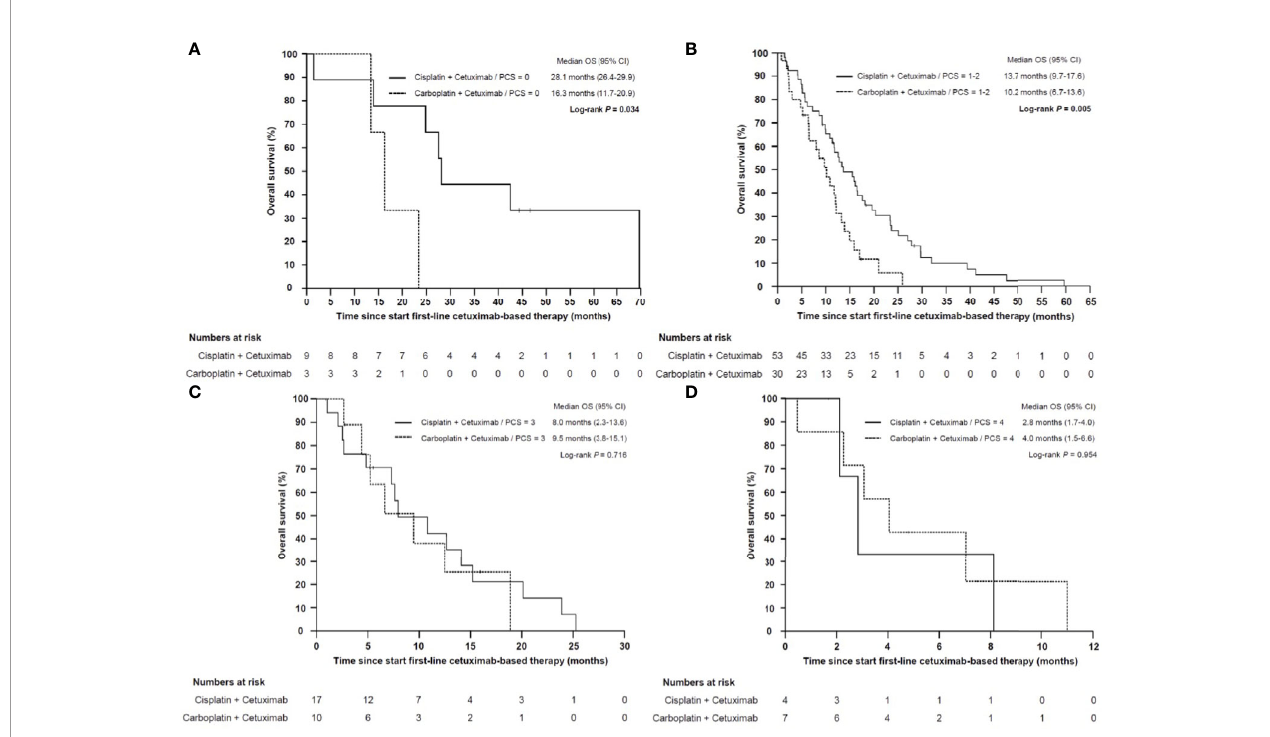
FIGURE 9 | Kaplan – Meier plot for overall survival (OS) from start of cisplatin/cetuximab- vs carboplatin/cetuximab-based fi rst-line therapy in low (A) , intermediate (B) , high (C) and very high risk (D) sub-groups. (A) Patients with low (PCS = 0) or (B) intermediate risk (PCS = 1 – 2) who were treated with cisplatin/cetuximab had a statistically signi fi cant prolonged overall survival compared to carboplatin/cetuximab ( P = 0.034 and P = 0.005, respectively). (C) In high risk (PCS = 3) and (D) very high risk subgroups (PCS = 4) the prognosis remained poor regardless whether cisplatin or carboplatin was administered ( P = 0.716 and P = 0.954,